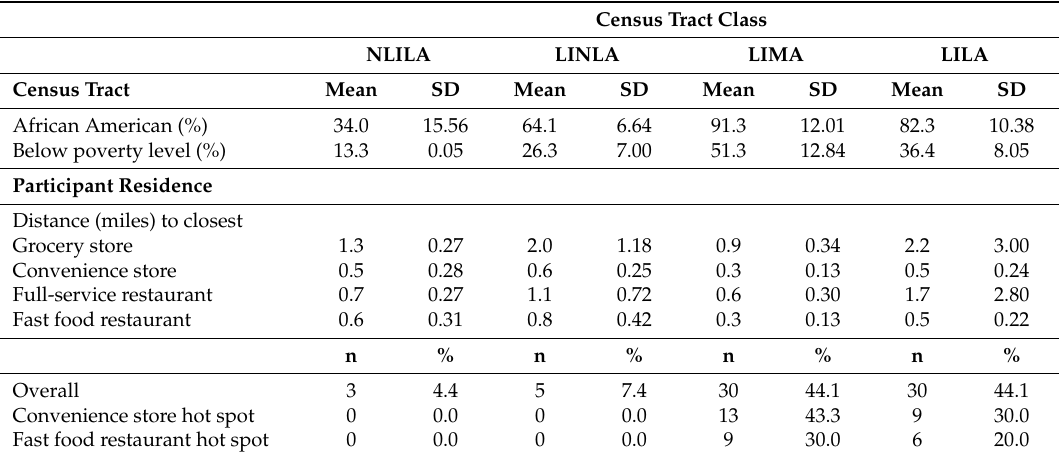
Table 3. Characteristics of Delta Healthy Sprouts participants’ residence by census tract class.